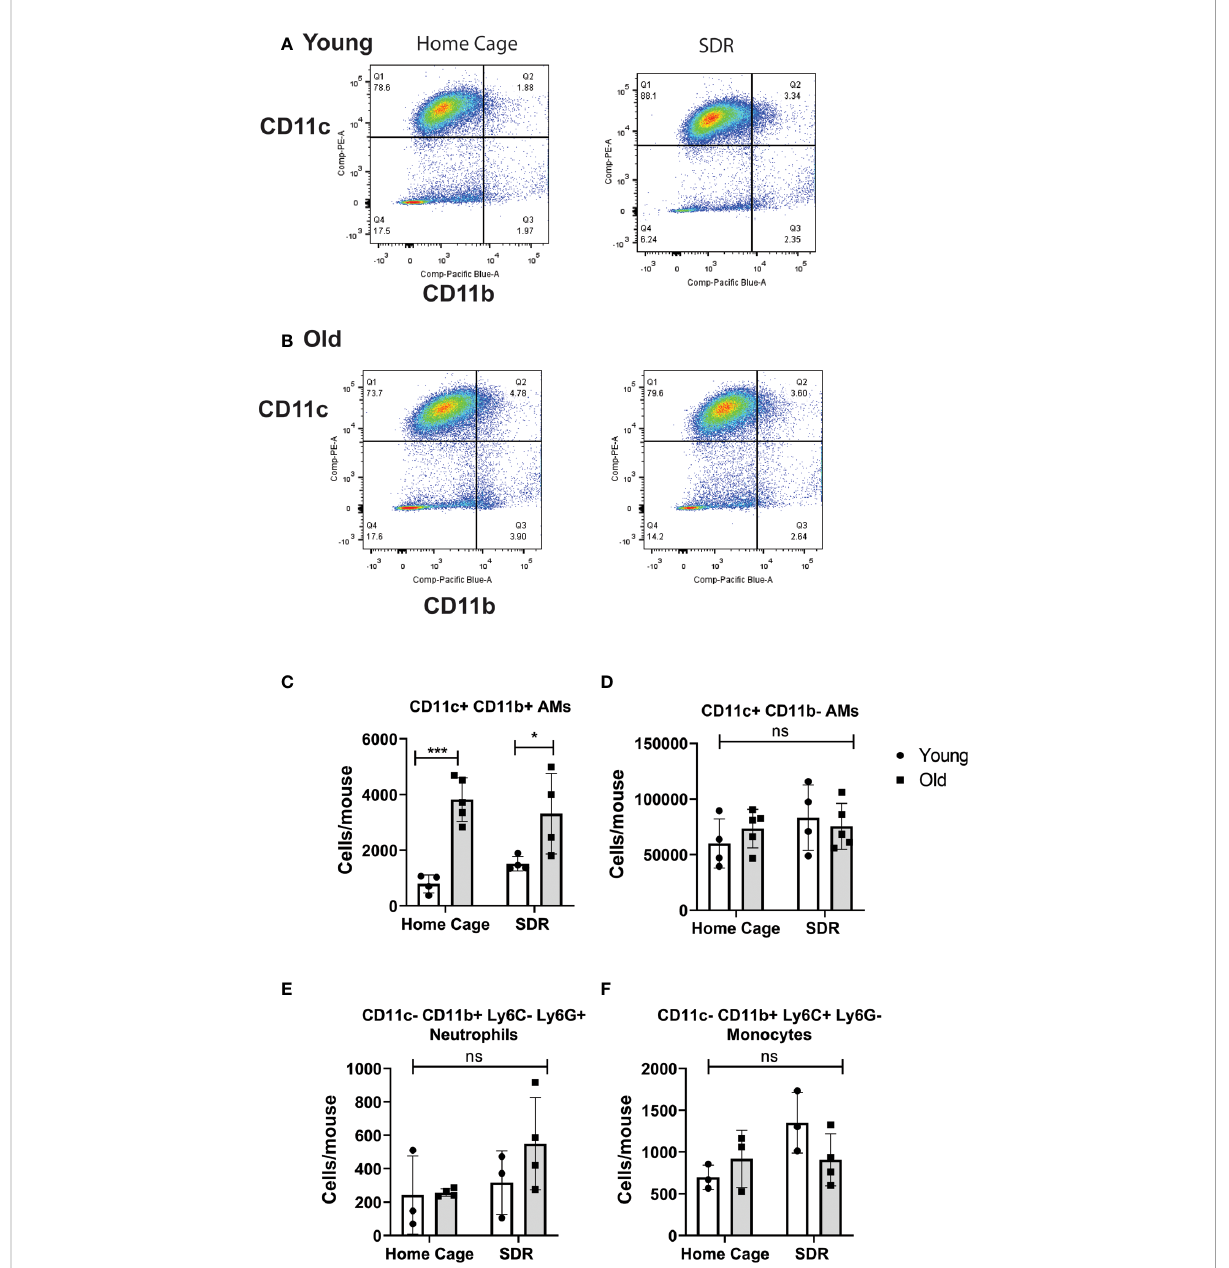
FIGURE 1 Flow cytometry analysis of myeloid cells in BAL fl uid from Home Cage and SDR mice. CD11c/CD11b fl ow plots of BAL cells from young (A) and old (B) mice. CD11c + CD11b - AMs are in quadrant 1. CD11c + CD11b + AMs are in quadrant 2. Monocytes and neutrophils present in the CD11c - CD11b + cells (quadrant 4) were detected using antibodies to Ly6G and Ly6C. Cell numbers of each population present in BAL fl uid were determined. (C) CD11c + CD11b - AM population (D) CD11c + CD11b + AM population (E) Neutrophils (F) Monocytes. Each symbol represents cells present in individual mice. Statistical analysis was performed by one-way ANOVA with Tukey multiple-comparisons post hoc test. N=4-5 mice/ group. Data are shown as mean ± SE. * p < 0.05, *** p < 0.001. ns, non signi fi